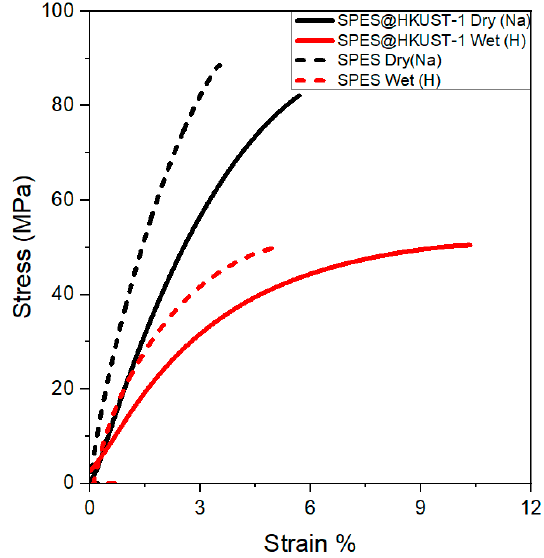
Figure 6. Tensile stress–strain curves for the SPES@HKUST-1 and pristine SPES membranes at 30 °C.